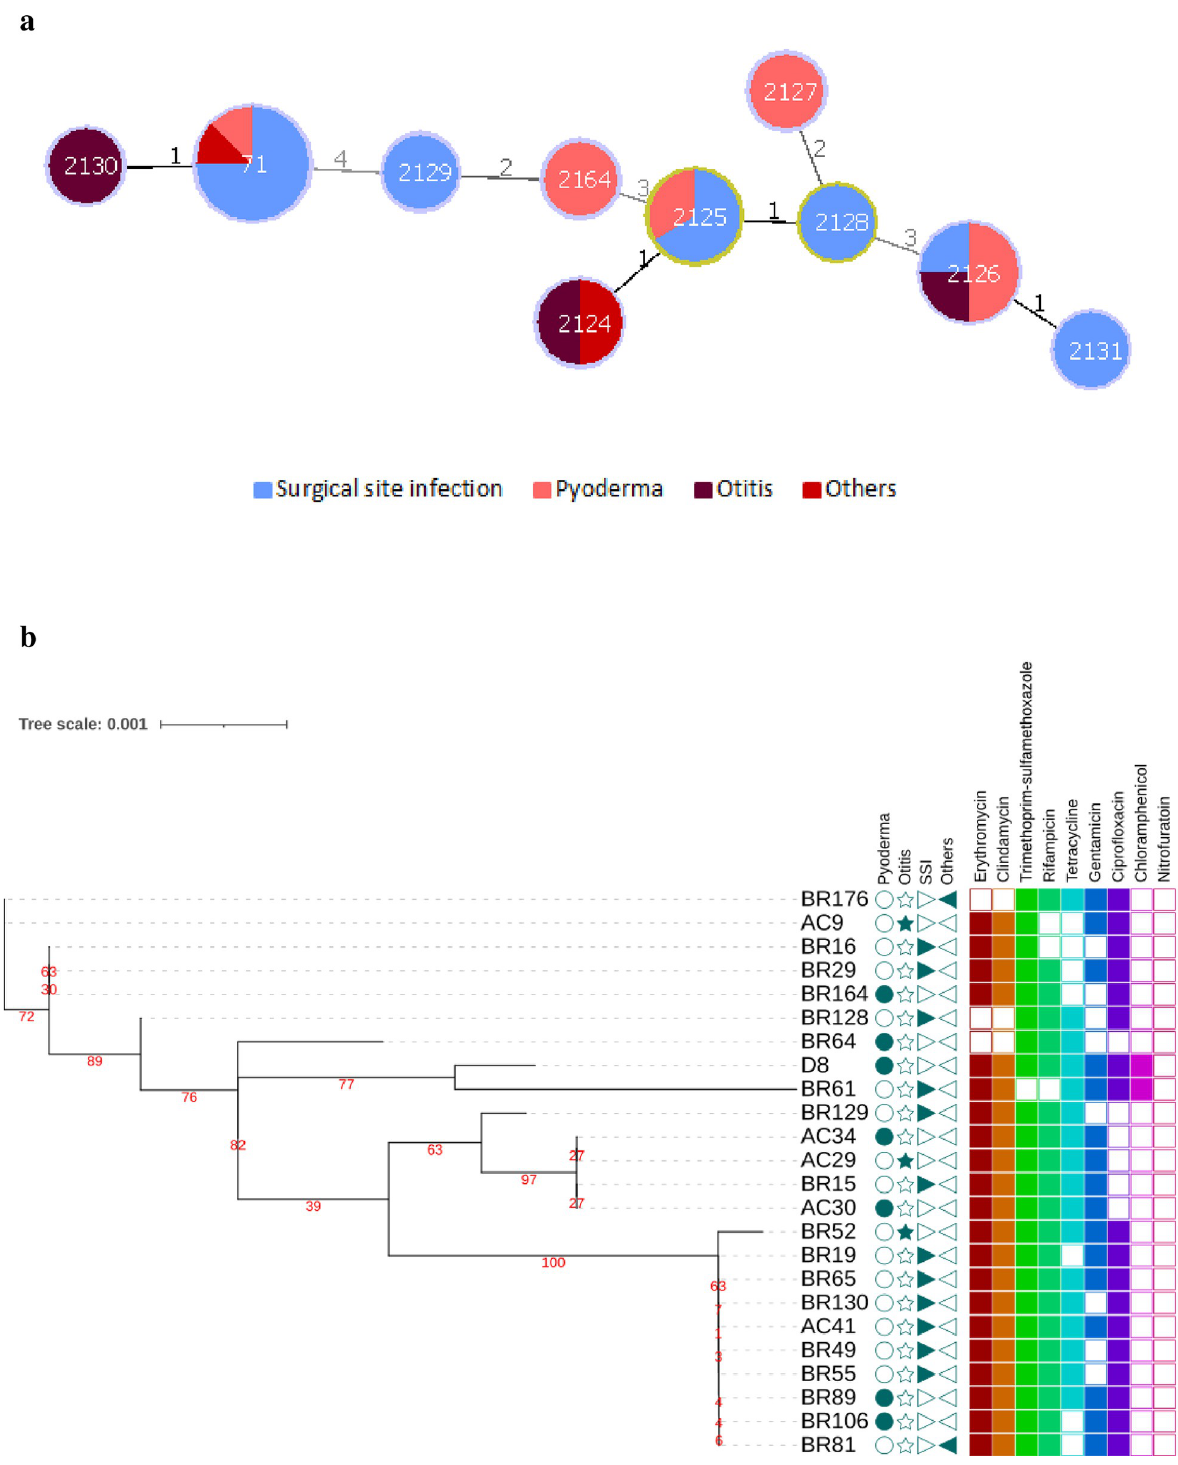
Fig 3. Genetic relationship of MRSP from dogs in Belo Horizonte (2017–2020). a) Population snapshot of MRSP goeBURST full MST analysis. Line numbers and shading indicate the number of differing loci between STs and colors indicate the type of infection related to each ST. b) A phylogenetic tree based on the alignment of all MLST genes of each ST was inferred using iqTree; posterior probabilities are shown in red. Columns with triangles, circle and star indicate the site of infection of each isolate; colored squares’ columns indicate presence or absence of resistance to different classes of non-beta-lactams